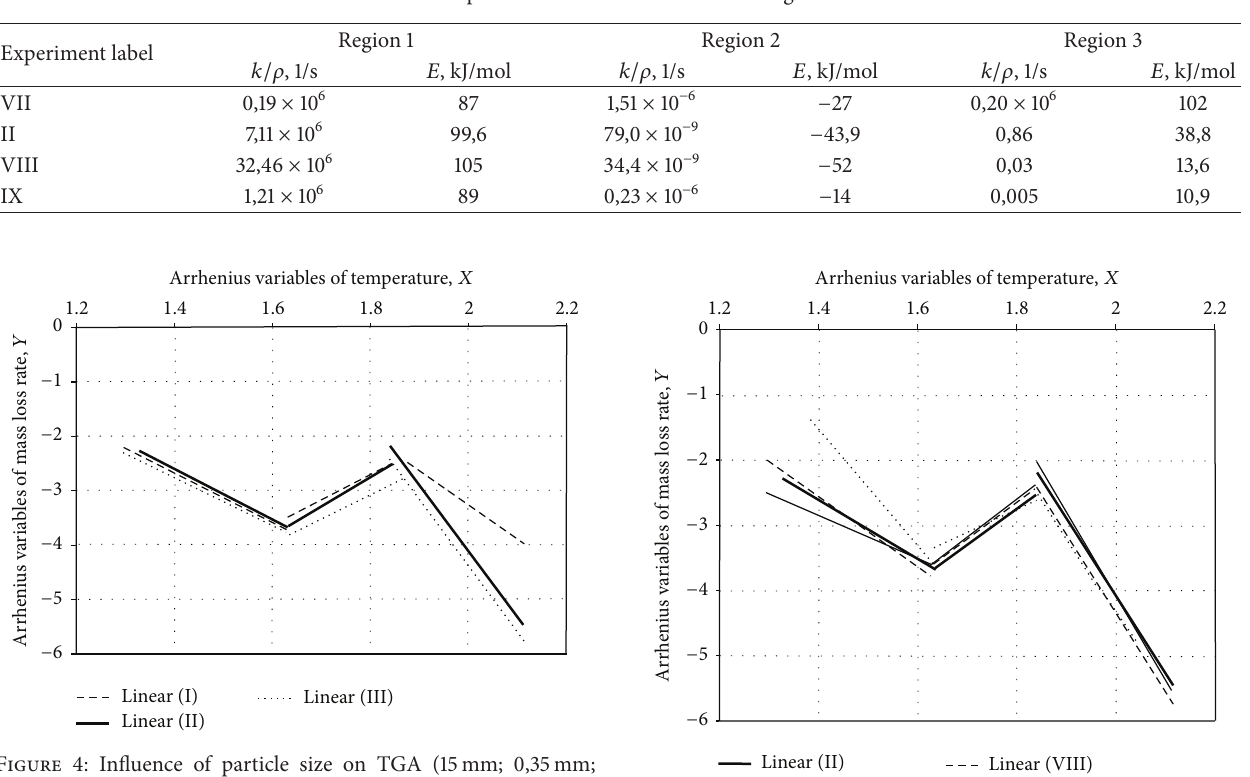
Table 6: Kinetic parameters of wheat straw at heating rate variation.